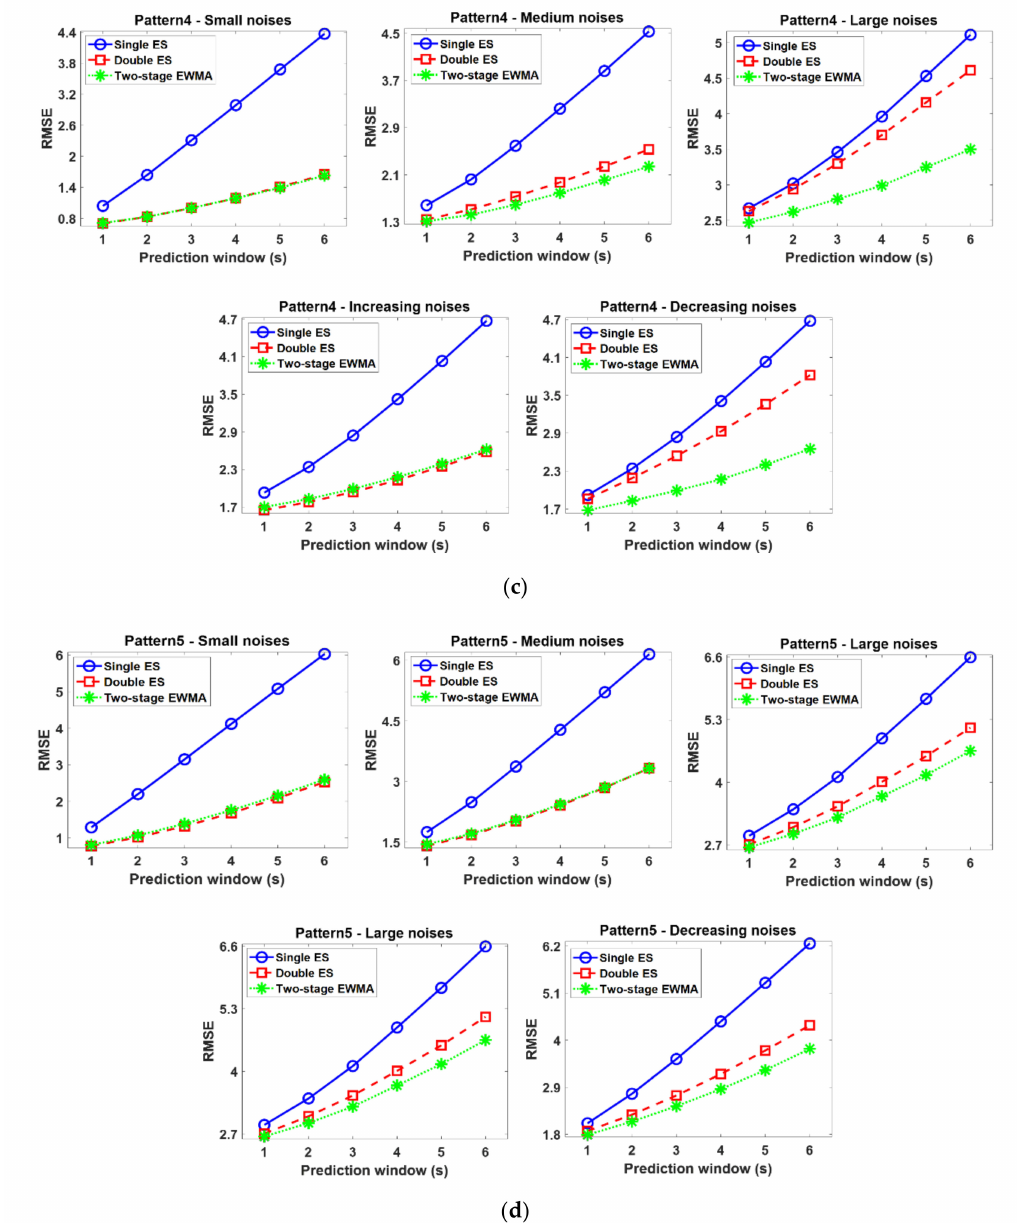
Figure 4. Comparison results between the single ES, double ES, and the two-stage EWMA in ( a ) Pattern 2, ( b ) Pattern 3, ( c ) Pattern 4 and ( d ) Pattern